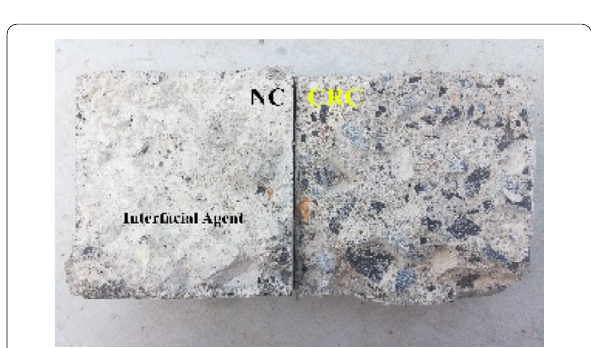
Fig. 8 Relationship between the bond splitting tensile strength and the RPs content in the